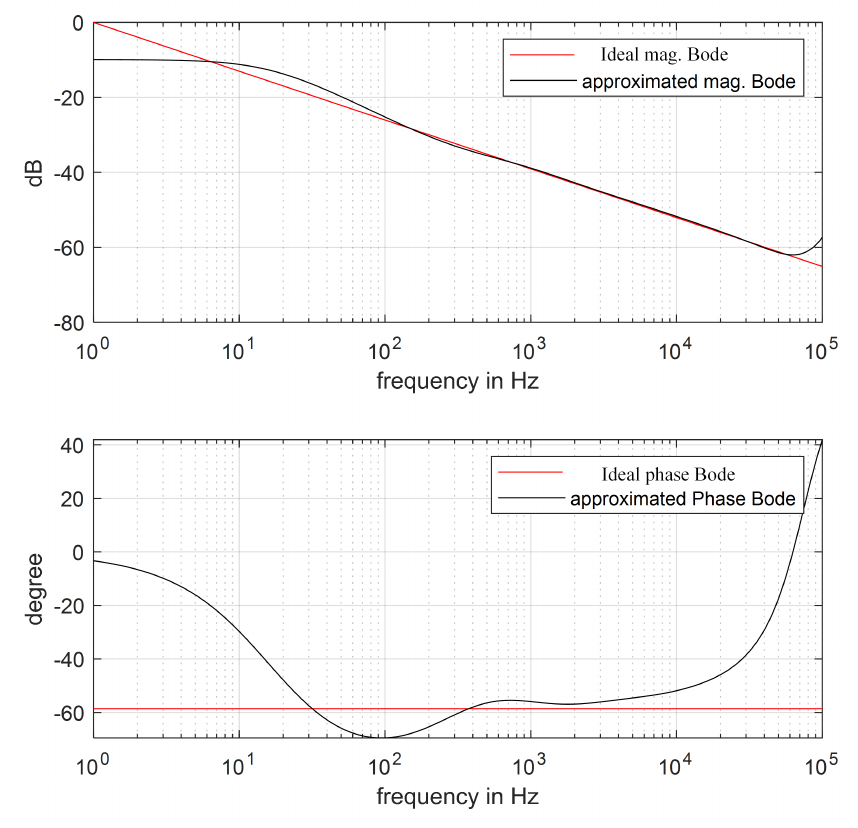
Figure 10. The comparison of discretization approximate bode graph and ideal bode graph of 1/ s α d